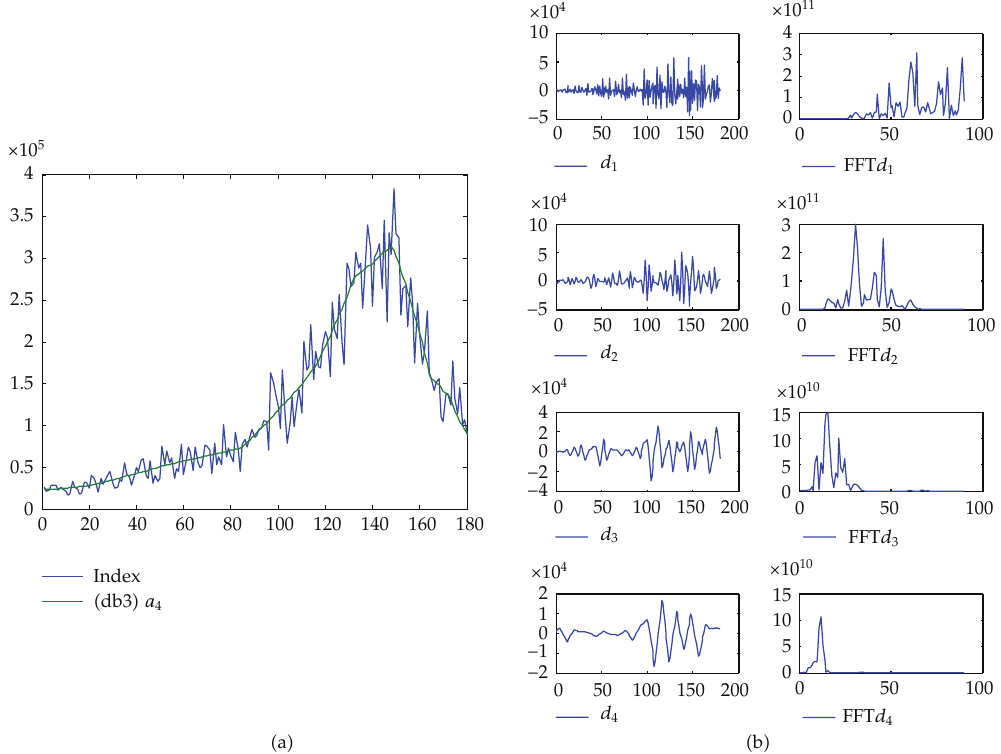
Figure 8: (cid:5) a (cid:6) db3 filter of SCTfe INDEX, (cid:5) b (cid:6) detail series and FFT of SCTfe